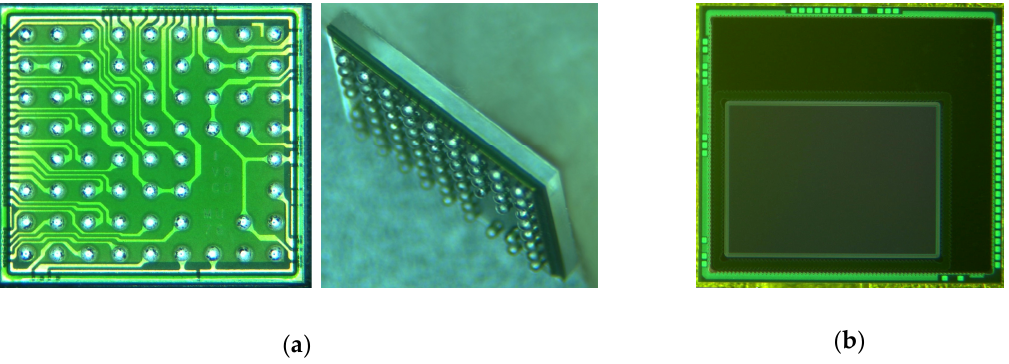
Figure 19. The outlook of CIS-WLCSP ( a ) BGA side; ( b ) Sensor side.